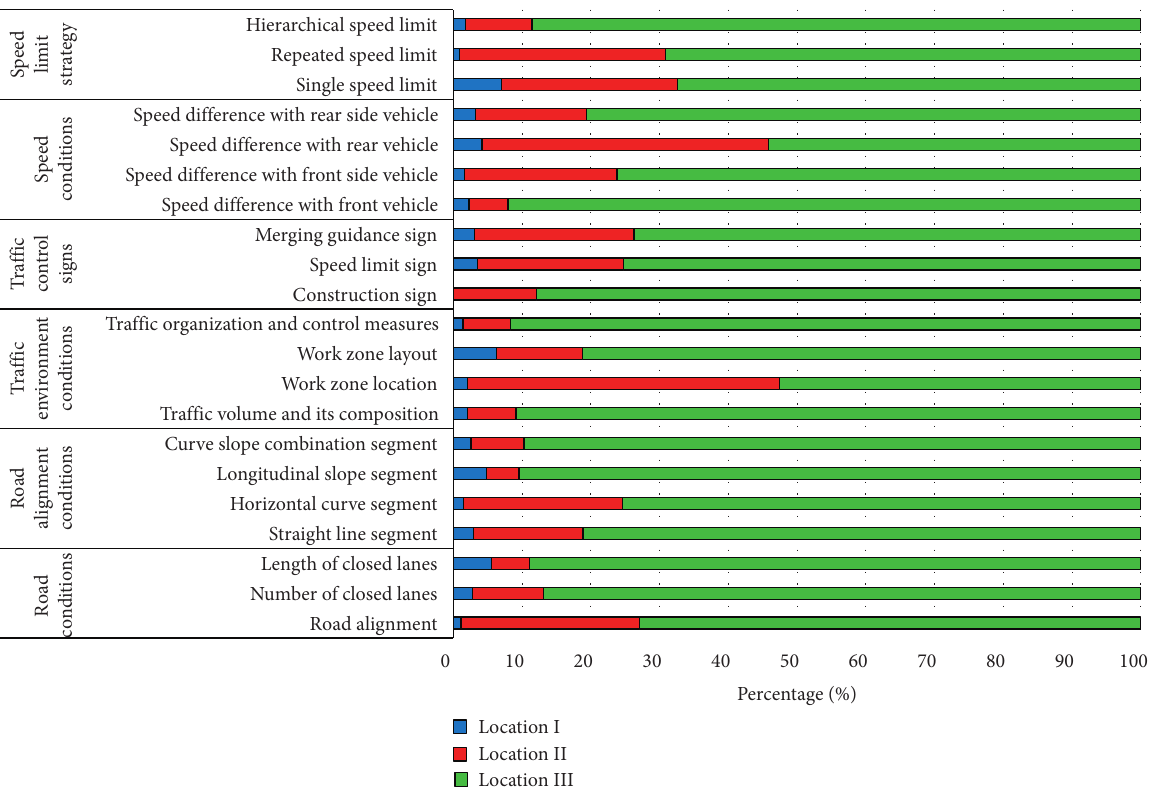
Figure 2: Relationship between factors of road environment and drivers’ preference to choosing merging